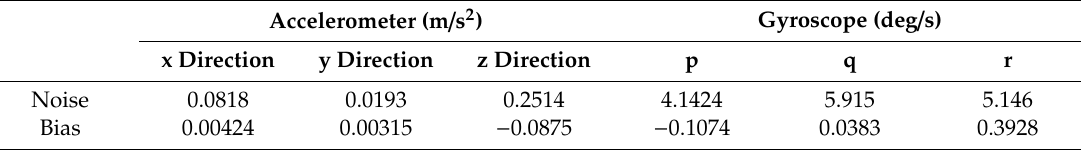
Table 4. The statistics of IMU measurement noise and bias in the cruising